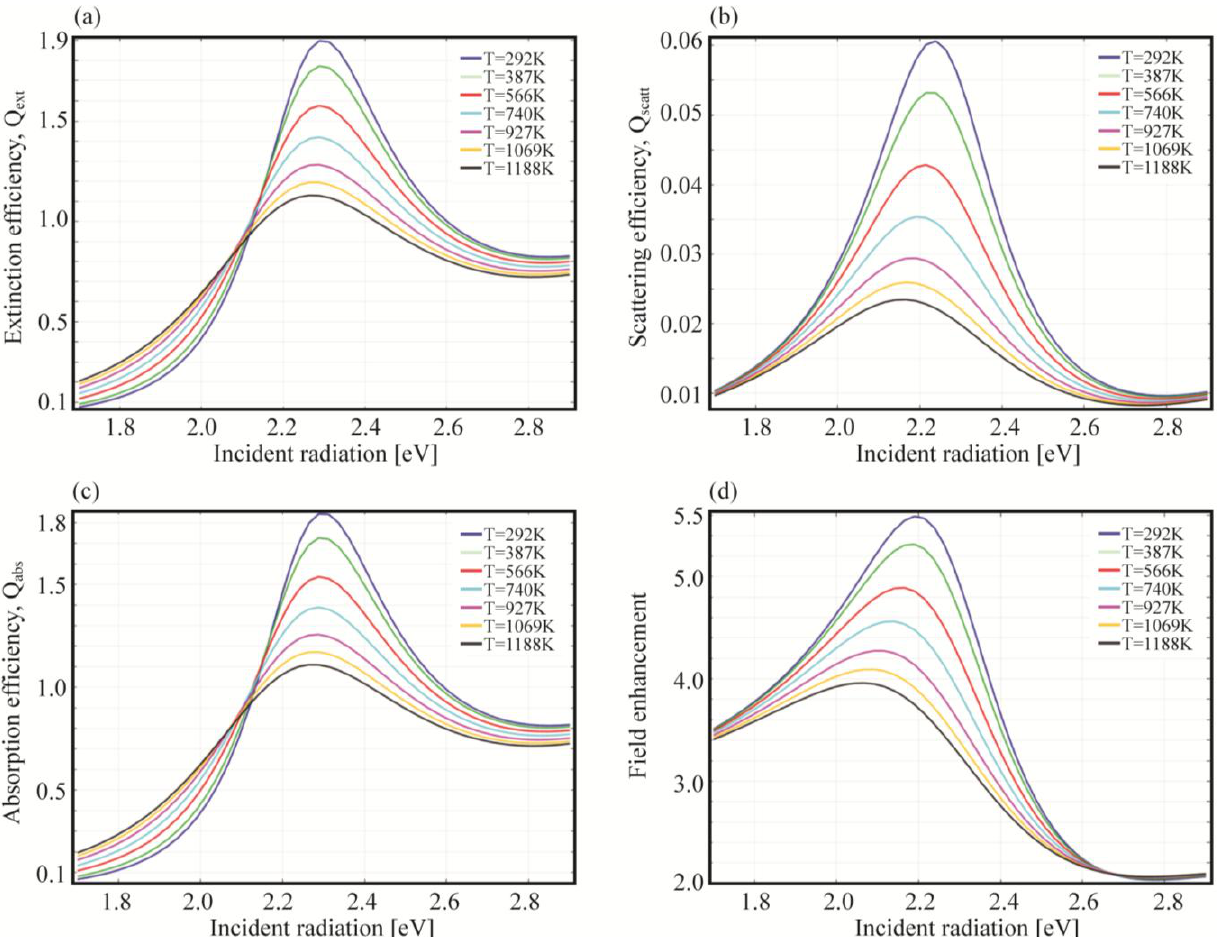
Figure 11. ( a ) Extinction efficiency; ( b ) scattering efficiency; ( c ) absorption efficiency; and ( d ) field enhancement for a gold nanospheres ( R = 10 nm) embedded in silica at different